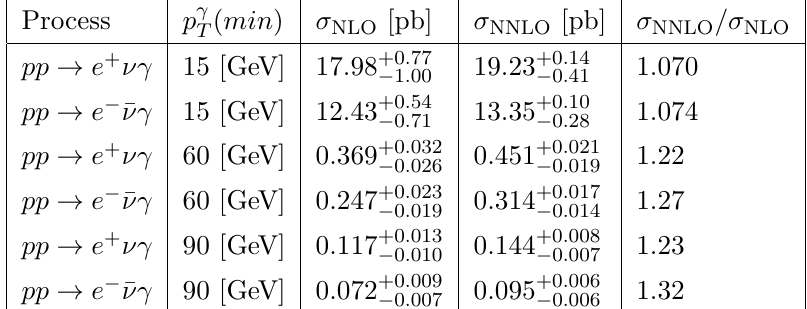
Table 5 . Our theoretical predictions for e + νγ and e − ¯ νγ at given without uncertainty, to illustrate the trend with p γ